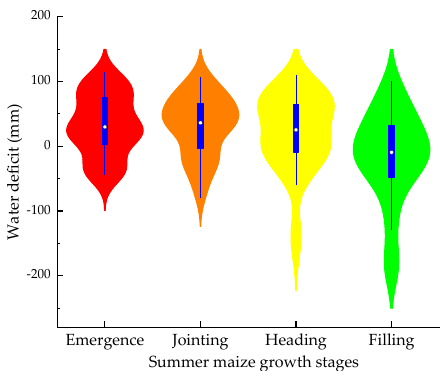
Figure 3. Water deficit at various stages of the summer maize growth season from 1970 to 2015 (emergence period (June 25 to July 24), jointing period (July 25 to August 15), heading period (August 16 to September 2), filling period (September 3 to September 30)).